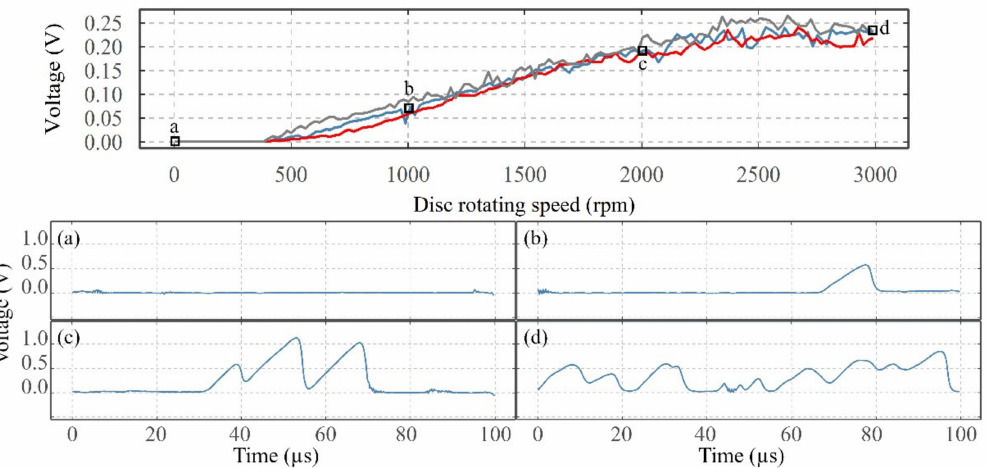
Figure 8. The average VADC as a function of a variation in speed and the snapshots of the voltage sampled at 5 MHz; ( a ) at 0 rpm, ( b ) at 1000 rpm, ( c ) at 2000 rpm and ( d ) at 3000 rpm.